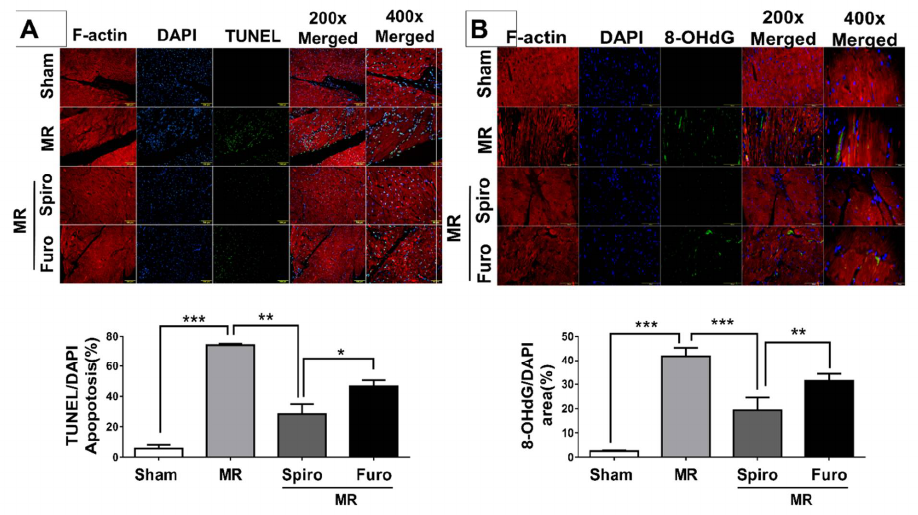
Figure 4. Mineralocorticoid receptor antagonists attenuate suppressed mitral regurgitation (MR)-induced cardiomyocyte apoptosis. ( A ) Representative heart sections with TUNEL staining for apoptosis detection (green) in 200 × and 400 × magnificence of scales; scale bars, 100 µ m (top panel). Quantification of cardiac apoptosis in the indicated groups of rats (bottom panel). ( B ) Representative and quantified ROS expressions using hydroxydeoxyguanosine (8OHdG) staining. Data are expressed as the mean ± standard deviation (S.D.). * p < 0.05, ** p < 0.01, and *** p < 0.001 for differences from each group.